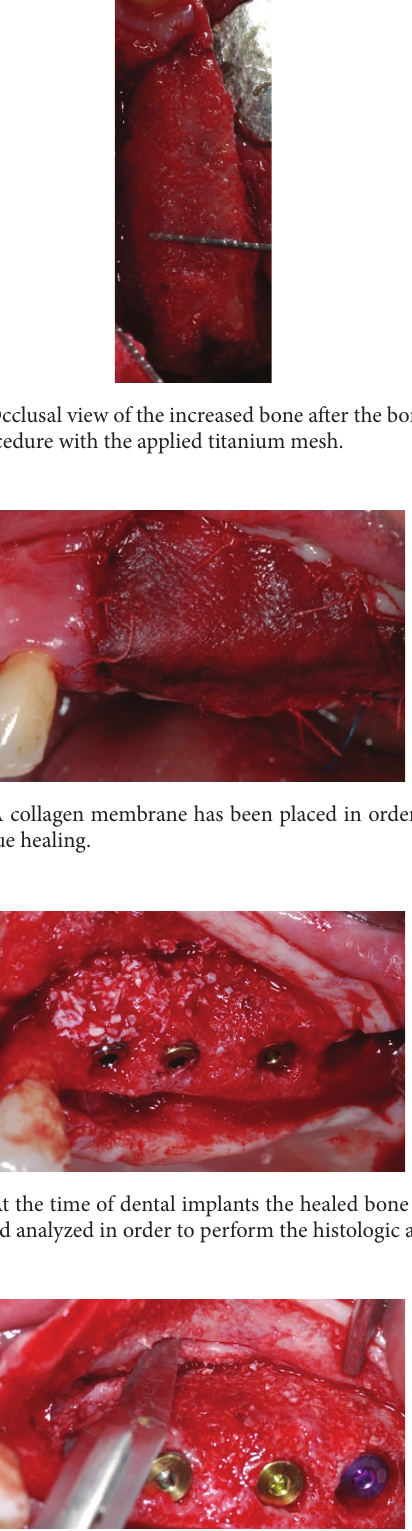
Figure 10: Dental implant was placed and periosteal incision has to be made in order to have a complete soft tissue covering of the dental implants placed.